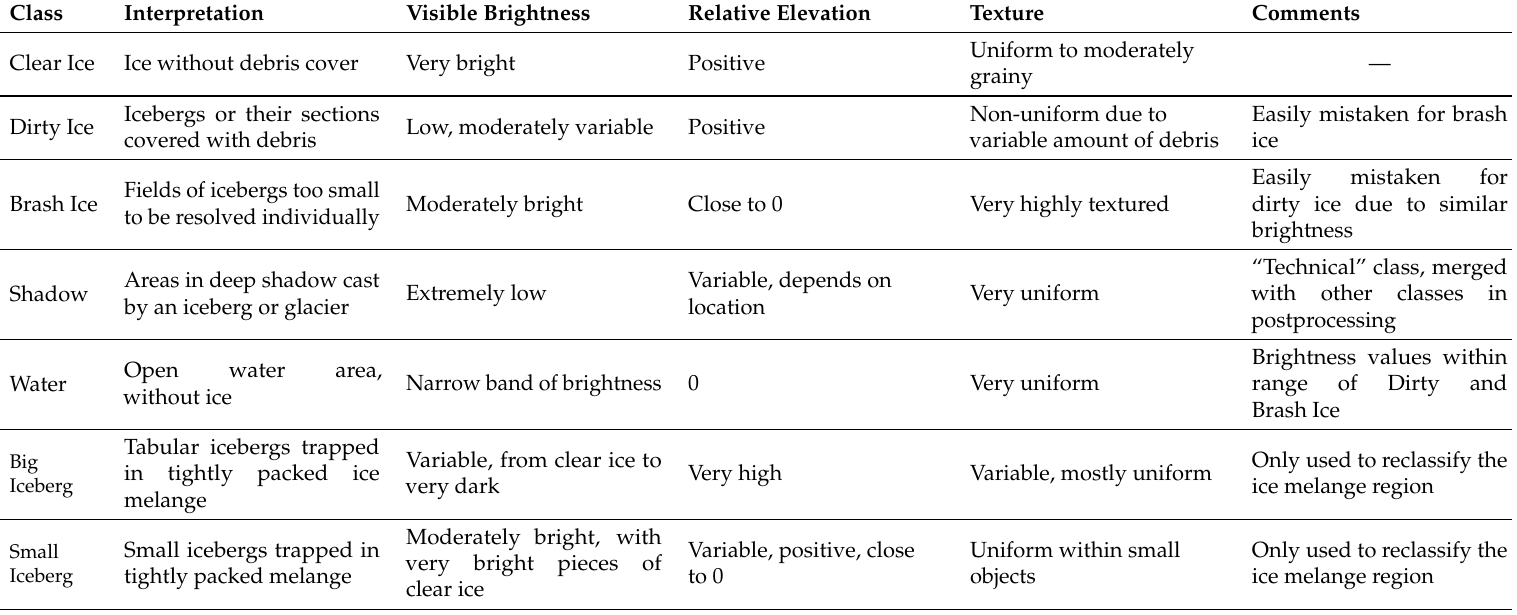
Table 2. Description of image classes used to classify the image